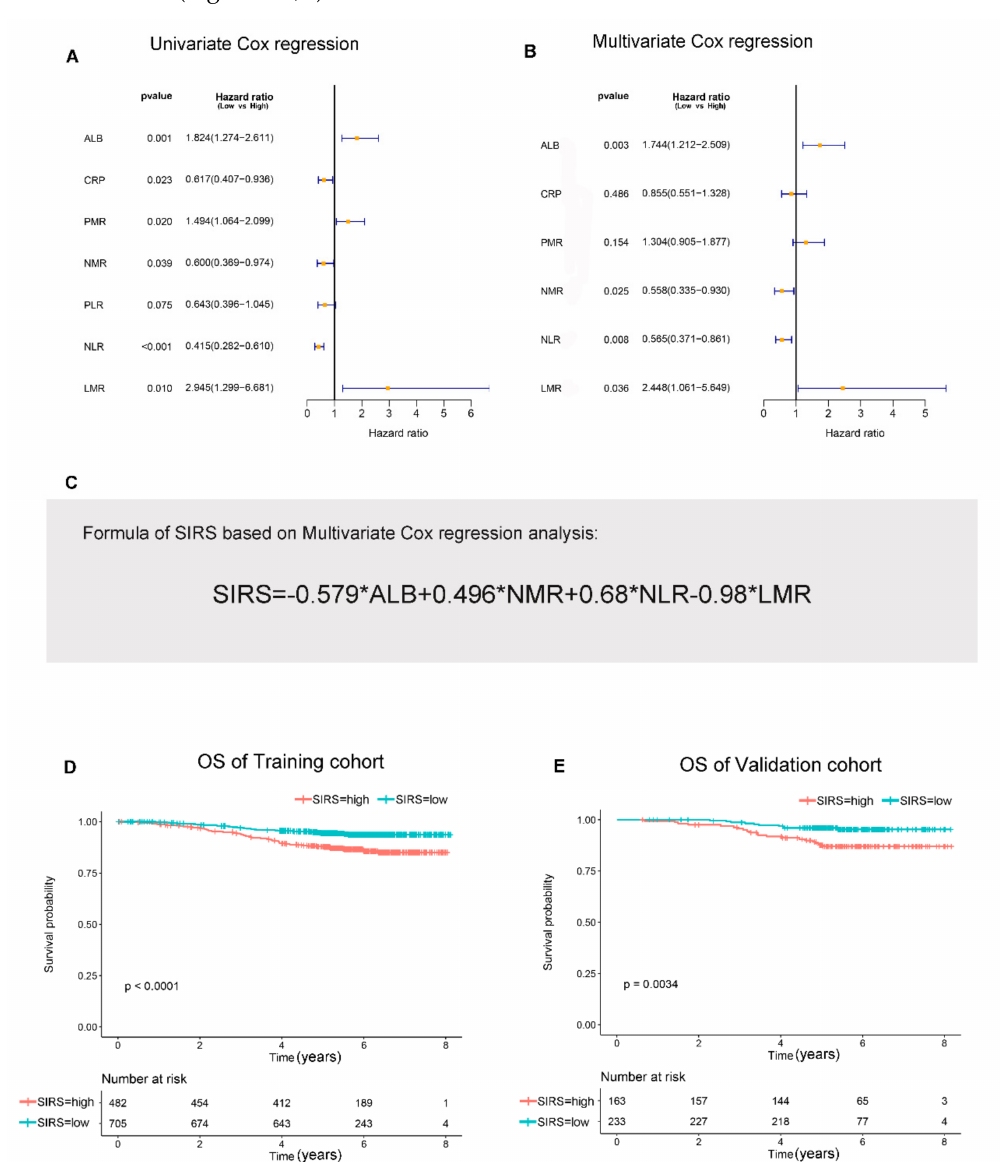
Figure 1. SIRS is associated with OS in patients with breast cancer. ( A , B ). Results of the univariate Cox regression analysis and multivariate Cox regression analysis between hematological markers of inflammation and overall survival